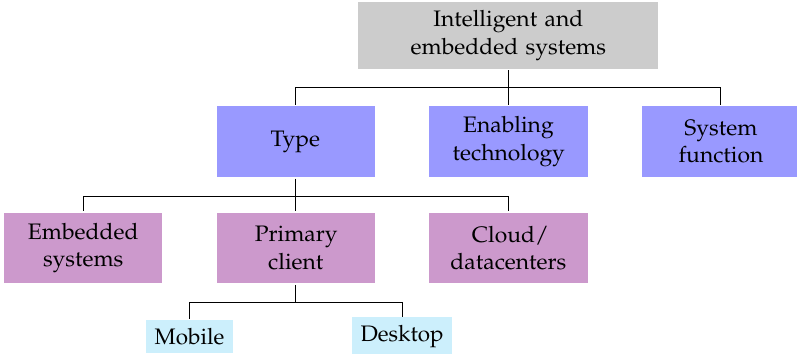
Figure 1. Computer systems basic taxonomy based on their type, enabling technology and system